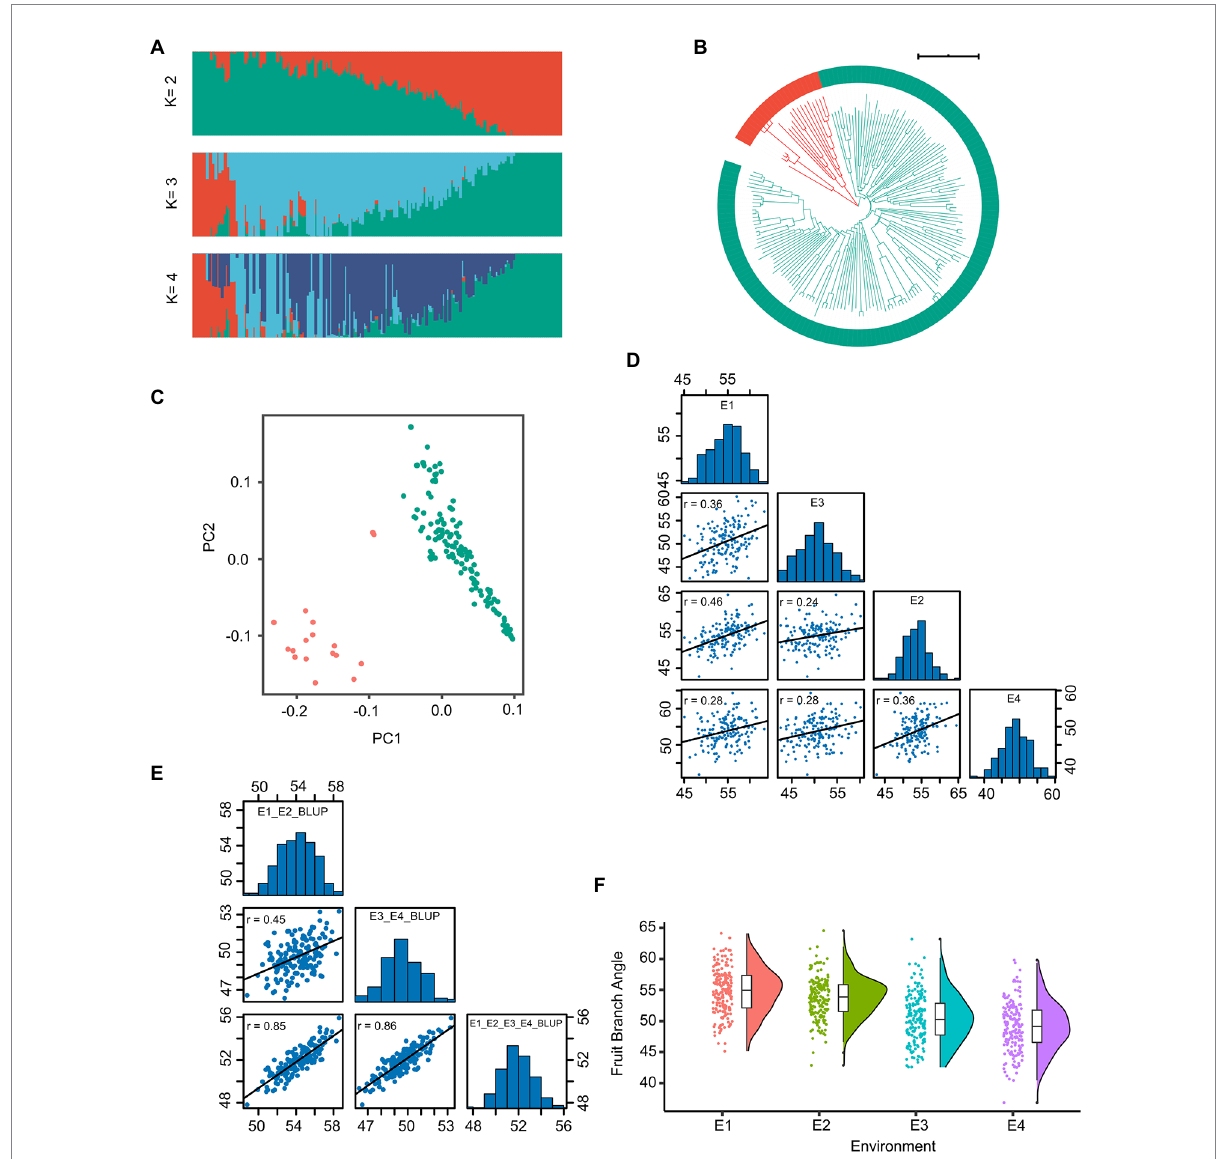
FIGURE 1 The genotype and phenotype analysis of the 163 cotton accessions. (A) Individual ancestry coefficients of 163 cotton accessions determined using ADMIXTURE with the number of ancestry kinships ‘K’ set to 2 or 4. Each accession is denoted by a vertical bar; the proportion of different colors in each bar indicates the proportion of genetic from each of the ancestral populations. (B) Phylogenetic tree of the population. (C) The plot of principal component analysis (PCA) was shown. (D) The histogram and correlation analysis of the frequency distribution of fruit branch angle (FBA) in E1, E2, E3, and E4. (E) The histogram and correlation analysis of the frequency distribution of the BLUP of FBA. (F) The boxplot of FBA in four environments were shown.